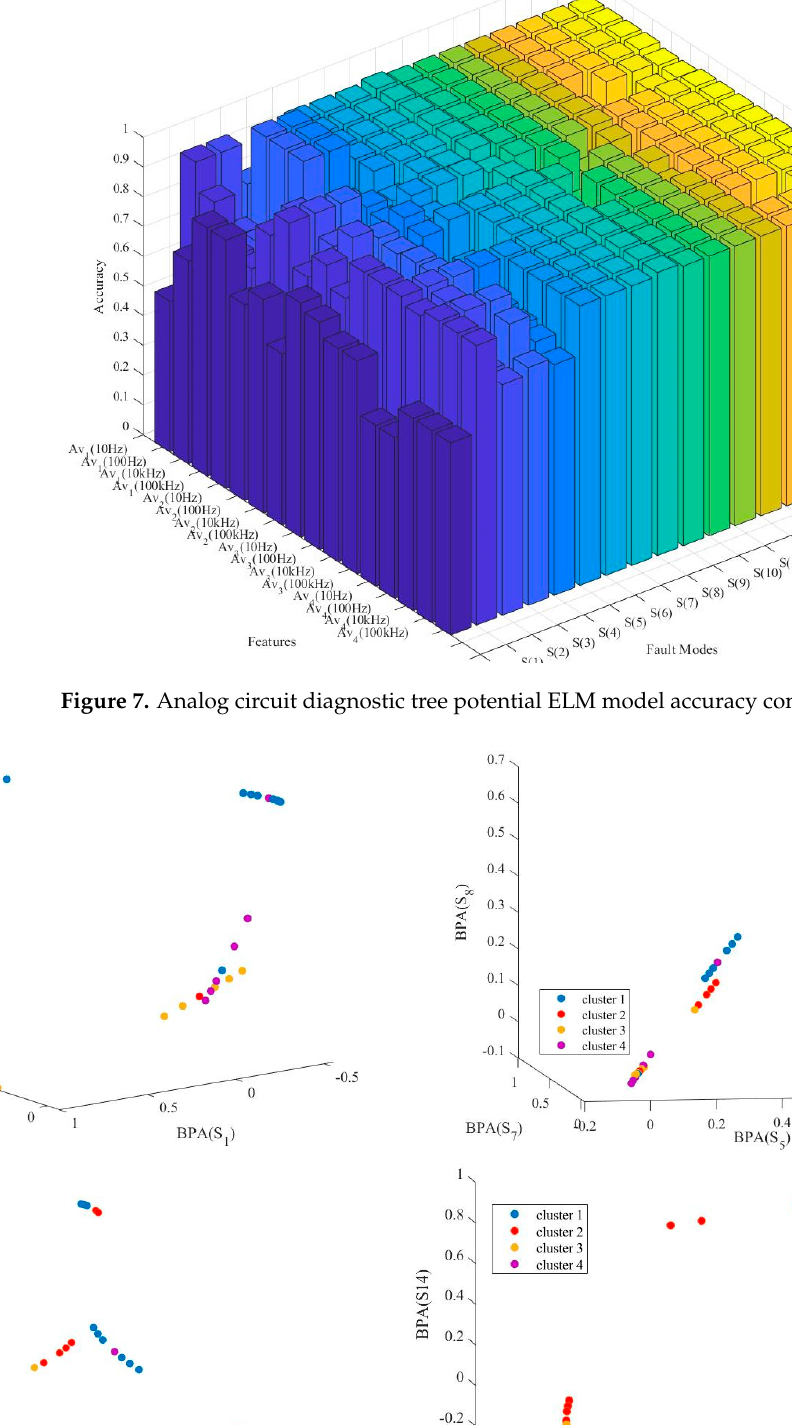
Figure 8. Potential ELM model accuracy comparison.